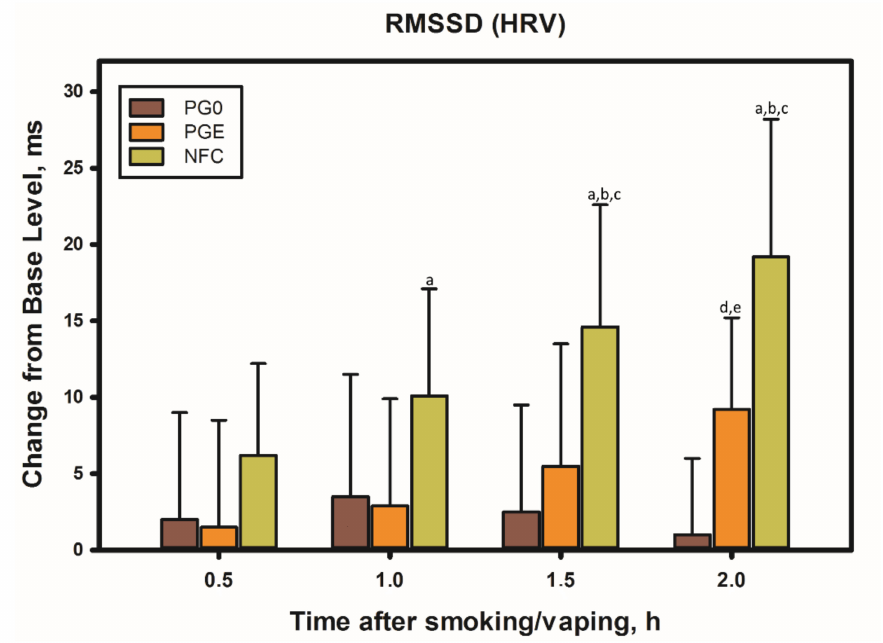
Figure 6. Influence of the smoke extract of the nicotine-free cigarette tar, free of the gas-phase components, on HRV in four non-smoking volunteers. PG0 refers to 25 puffs of the electronic cigarette with propylene glycol (control), and PGE pertains to 25 puffs of the electronic cigarette with the smoke extract, while NFC denotes 10 puffs of a Nirdosh nicotine-free cigarette. Designations of statistically significant differences ( p < 0.05): a—relative to the baseline in the experiment with smoking (t = 0 h), b—in the experiment with smoking relative to the electronic cigarette with propylene glycol (PG0), c—in the experiment with smoking relative to the electronic cigarette with the cigarette-smoke tar extract (PGE), d—in the experiment with the electronic cigarette with the cigarette-smoke tar extract relative to the baseline (t = 0 h), e—in the experiment with the electronic cigarette with the tar extract (PGE) relative to the electronic cigarette with propylene glycol